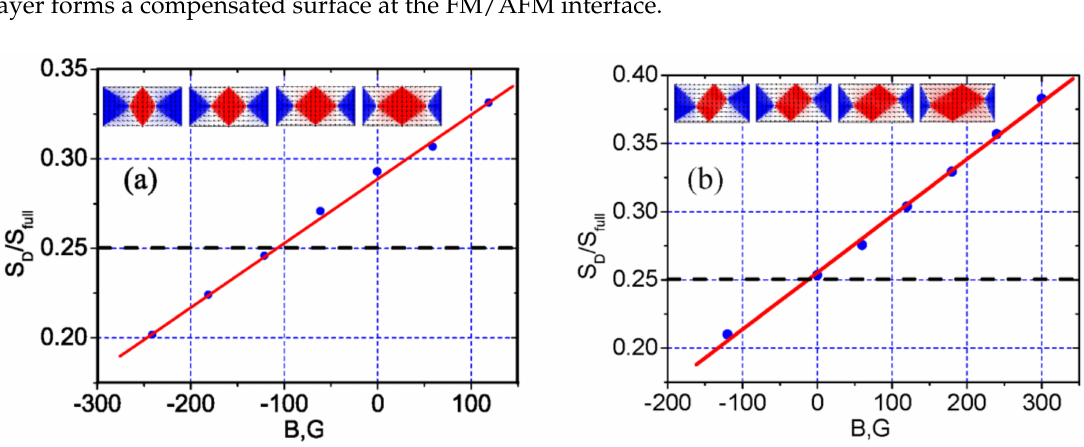
Figure 6. The calculated dependence of the central domain on the rectangle areas ratio against applied magnetic field. The exchange built-in field is perpendicular ( a ) or parallel ( b ) to the long side of the rectangle. The inserts display the calculated magnetic states of the Fe layer in magnetic fields − 300, − 120, 0, 120 ( a ) and − 120, 0, 120, 300 G ( b